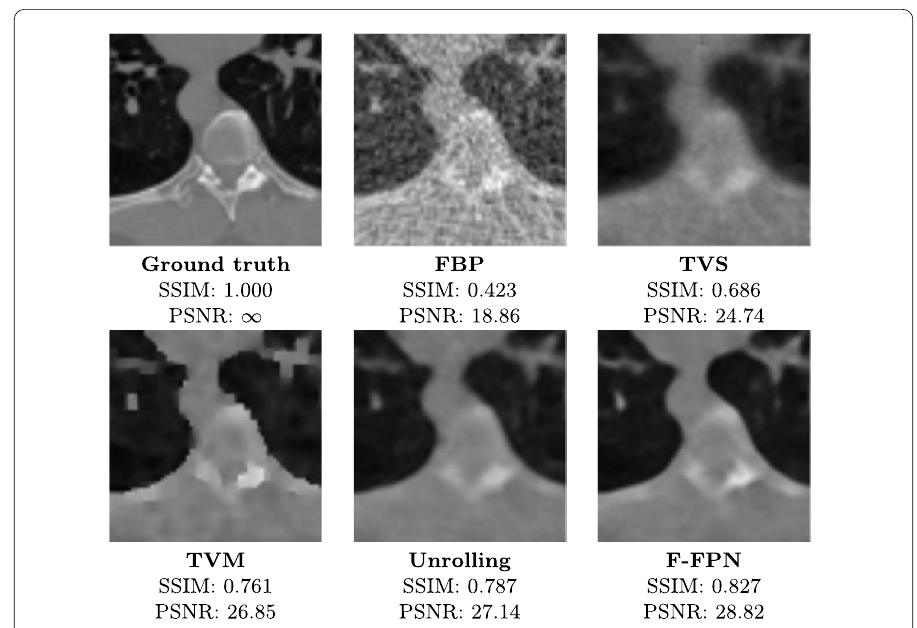
Figure 5 Zoomed-in LoDoPab reconstruction with test data of Figure 4 for each method: FBP, TVS, TVM, unrolling, and the proposed F-FPN.